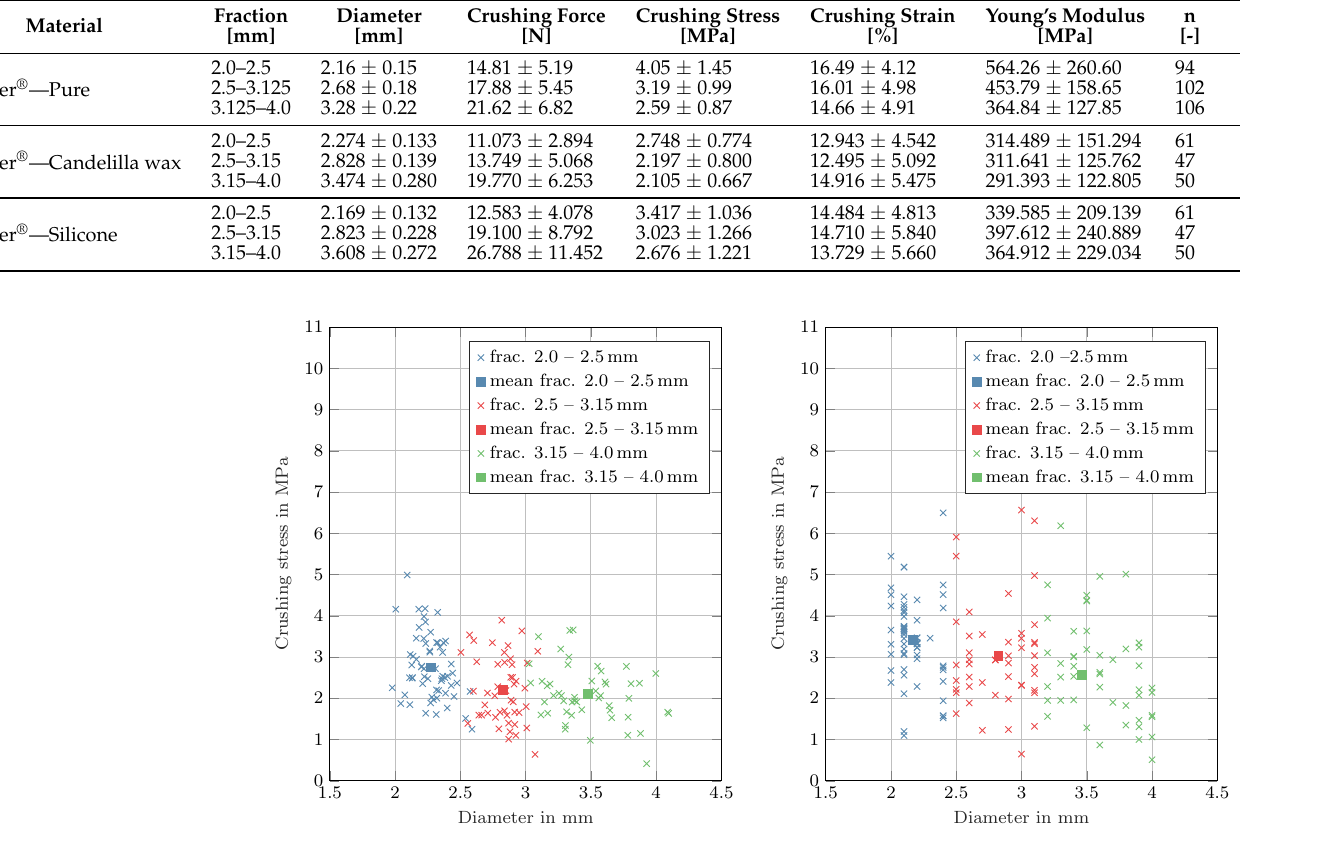
Table 2. Results from the single-particle compression test of uncoated and coated particles for all diameter fractions.